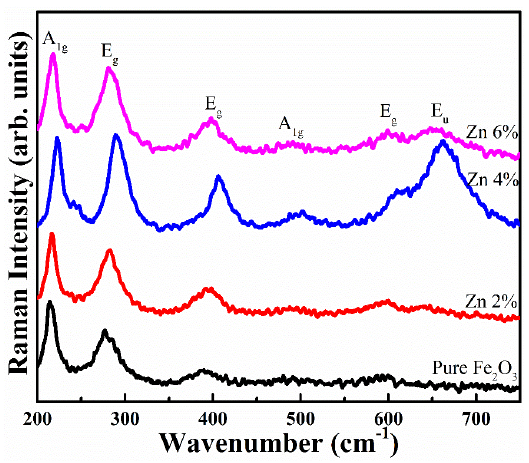
Figure 4. Raman spectrum of pure Fe 2 O 3 , Zn 2%, Zn 4% and Zn 6% nanoparticles. The assignment of Raman active modes are consistent with the group theory predicted for the space group R3c of hematite. Five phonon modes (2 A 1g and 3 E g ) of hematite corresponding to